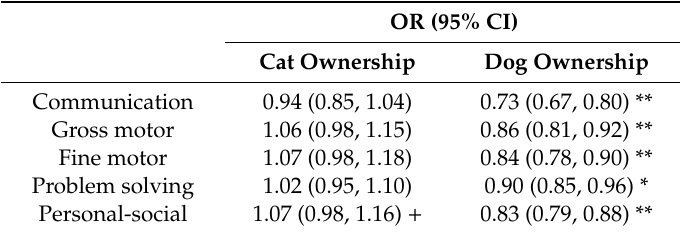
Table 3. Infant development delays at 12 months of age in association with cat and dog ownership at 6 months of